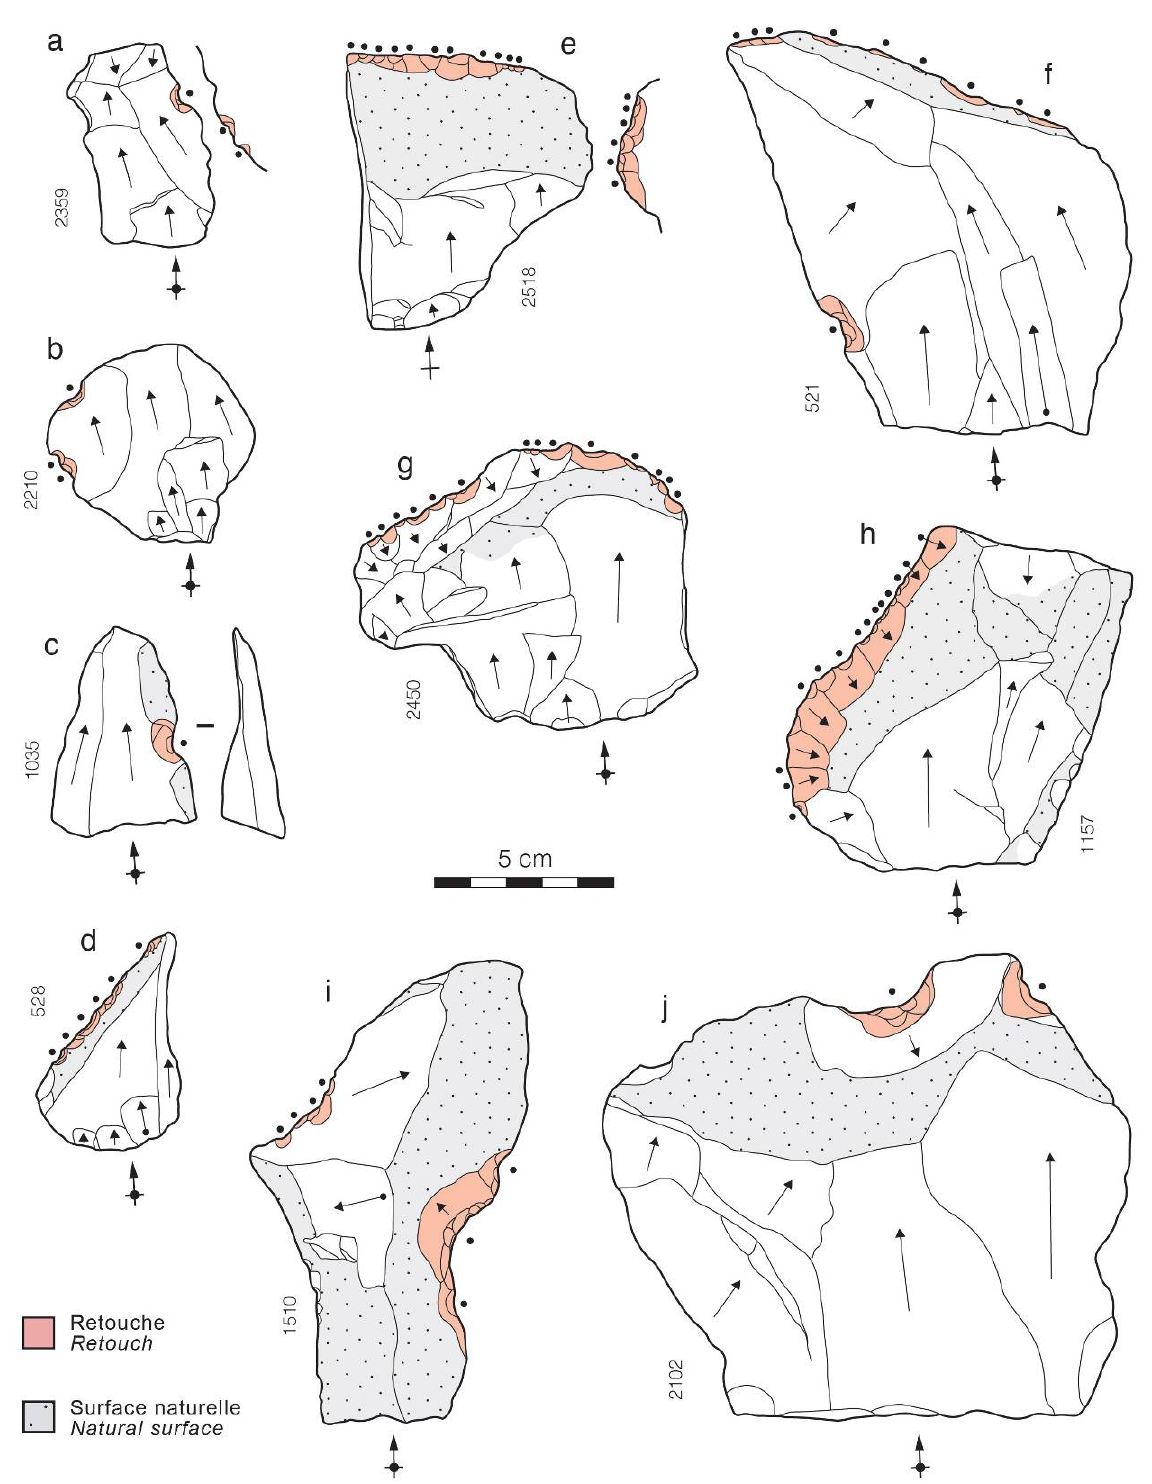
Figure 17. Outils sur éclat à Tanataetea. Figure 17. Flake tools at